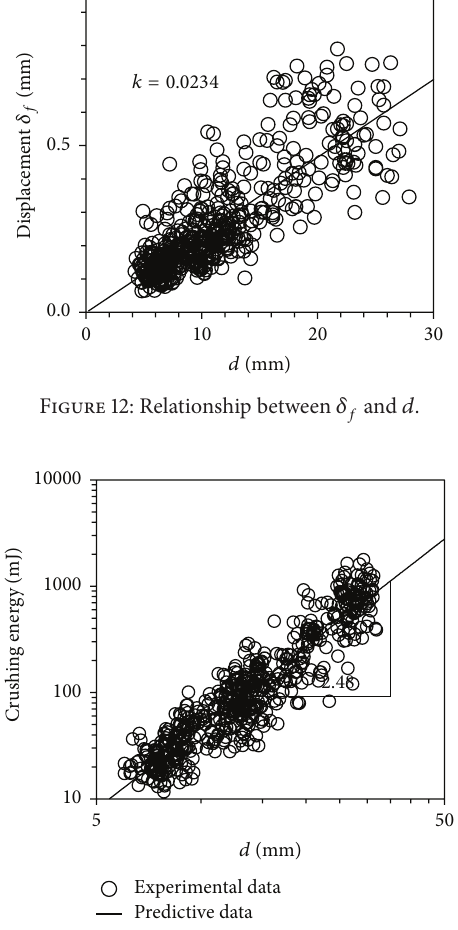
Figure 13: Comparison of predictions with experimental data of crushing